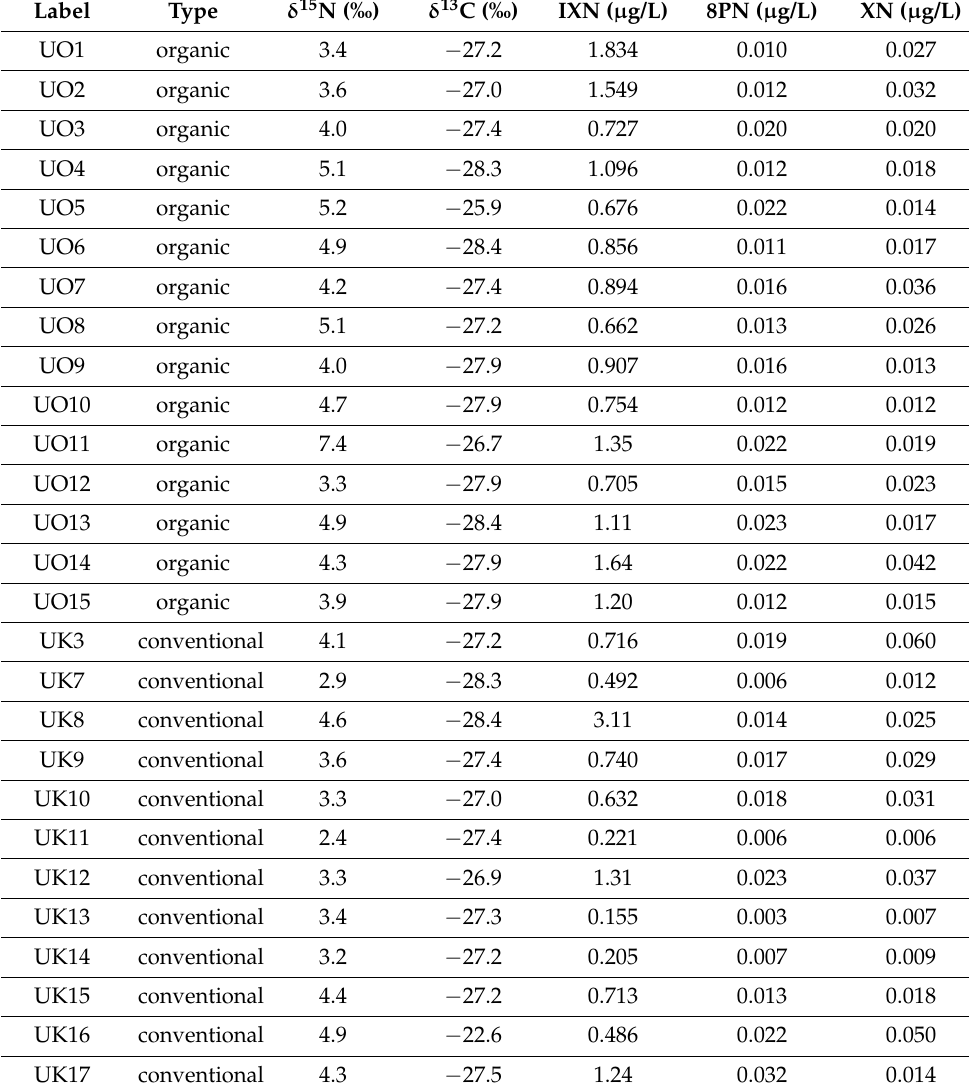
Table 2. Stable isotope data and results of the xanthohumol (XN), isoxanthohumol (IXN)